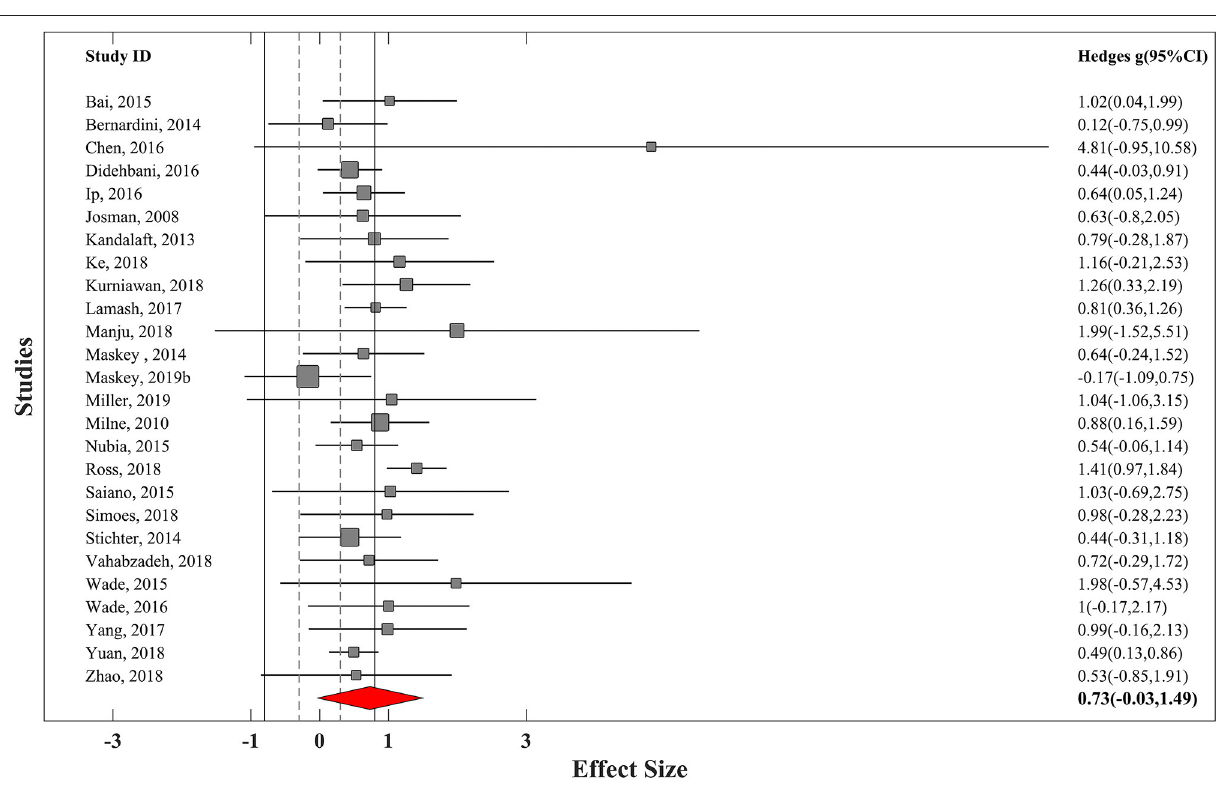
FIGURE 3 | Forest plot of overall effectiveness of VR training for uncontrolled trials with 95% confidence interval. Solid vertical lines represent strong effect size boundary ( g 0.8 and 0.8), and dashed vertical lines represent weak effect size boundary ( g = −